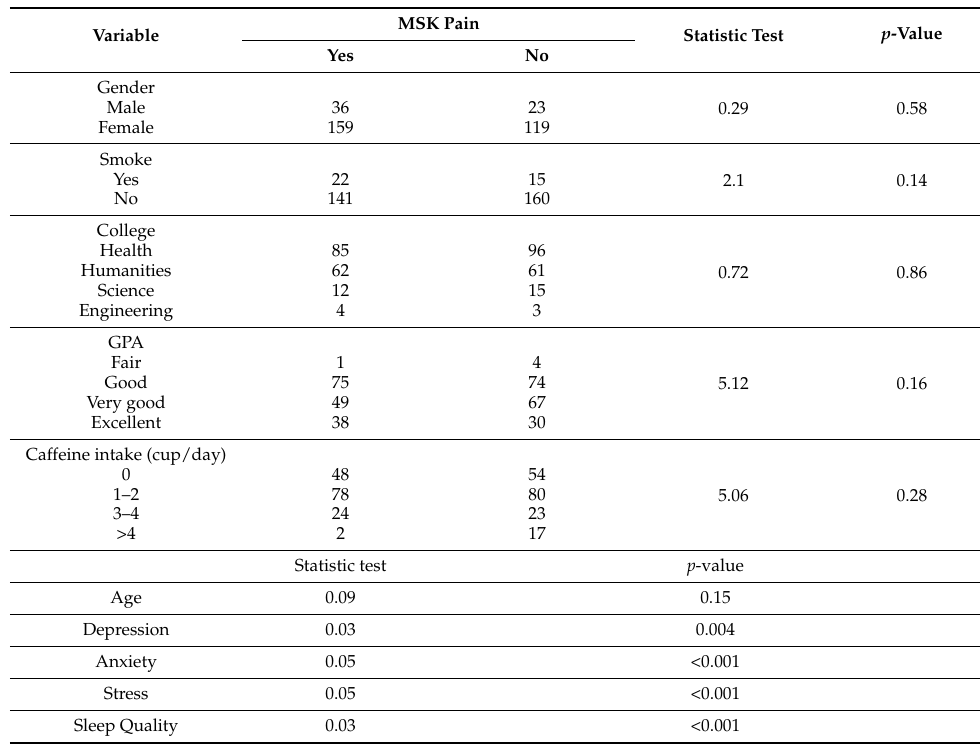
Table 5. Factors associated with reported MSKP in the past 7